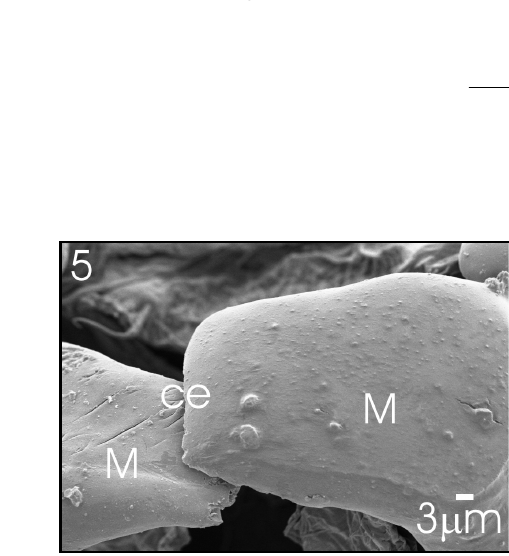
Fig. 5. The mandibles (M) were broad and flat and were not notched on the cutting edges (ce).